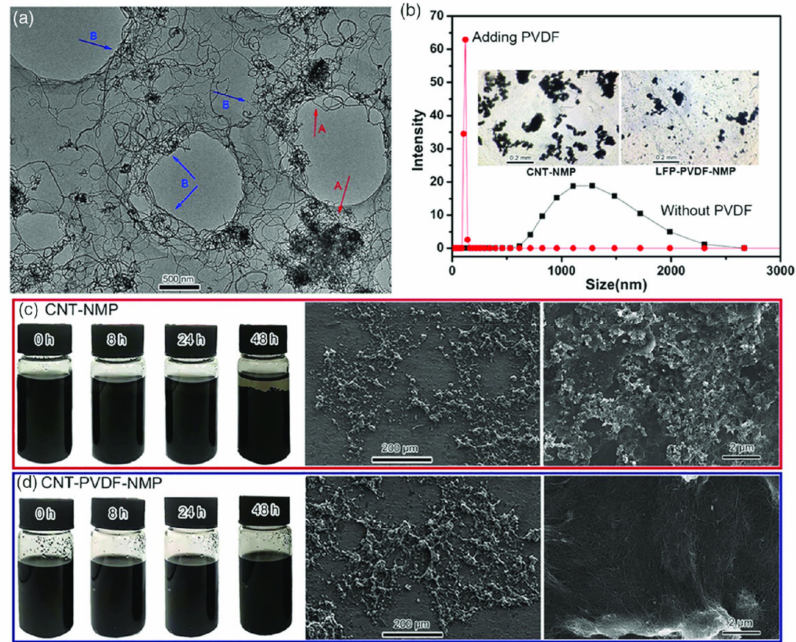
Figure 4. ( a ) TEM images of agglomerated CNT ( b ) Particle size distribution of agglomerated CNT ( c ) Sample image and SEM image of CNT, N-methyl pyrrolidone (NMP) ( d ) Sample image and SEM image of CNT/NMP/PVDF. (adapted with permission from Ref. [46]. 2020